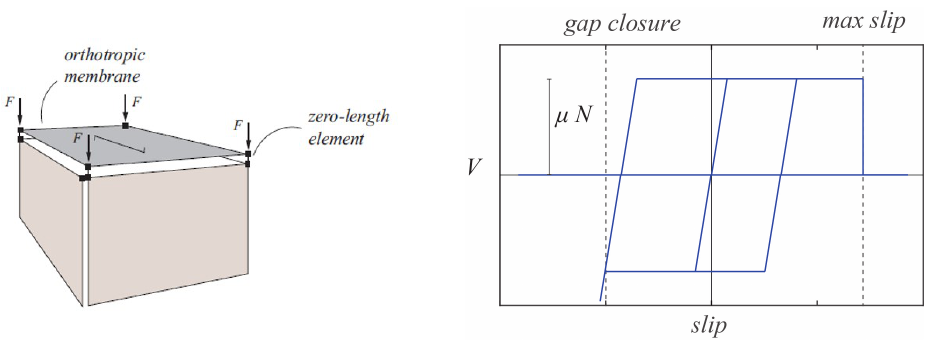
Figure 4. Equivalent frame model of wall-to-diaphragm connection